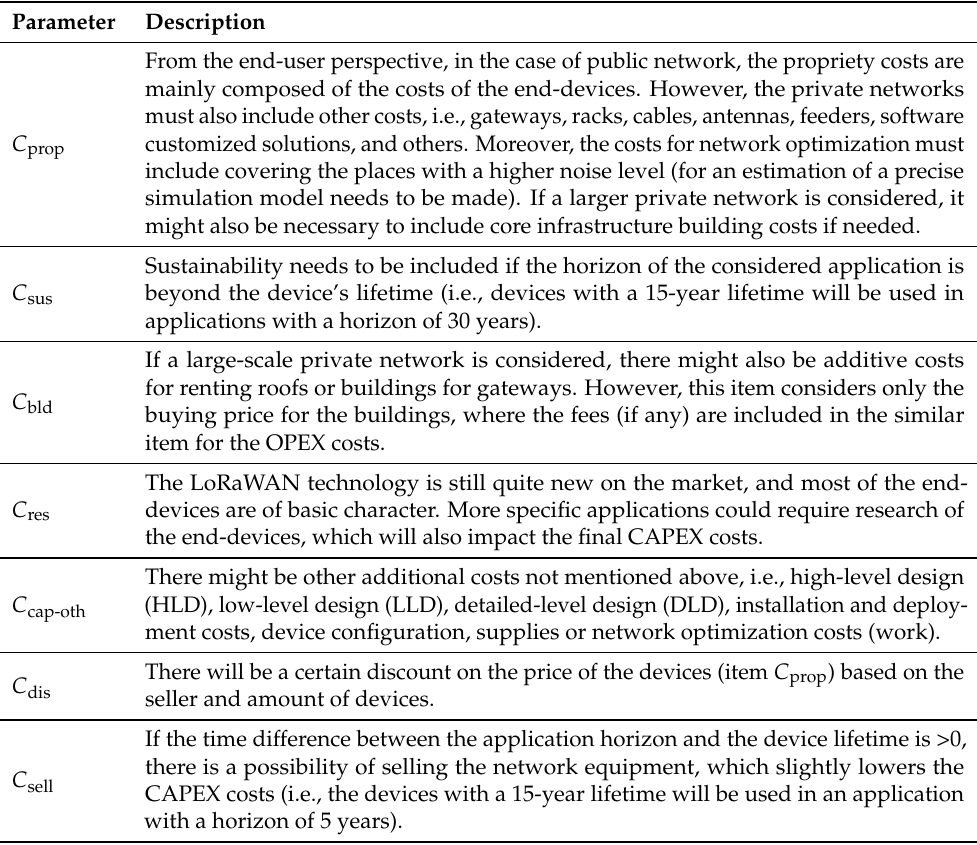
Table 5. The list of components of CAPEX